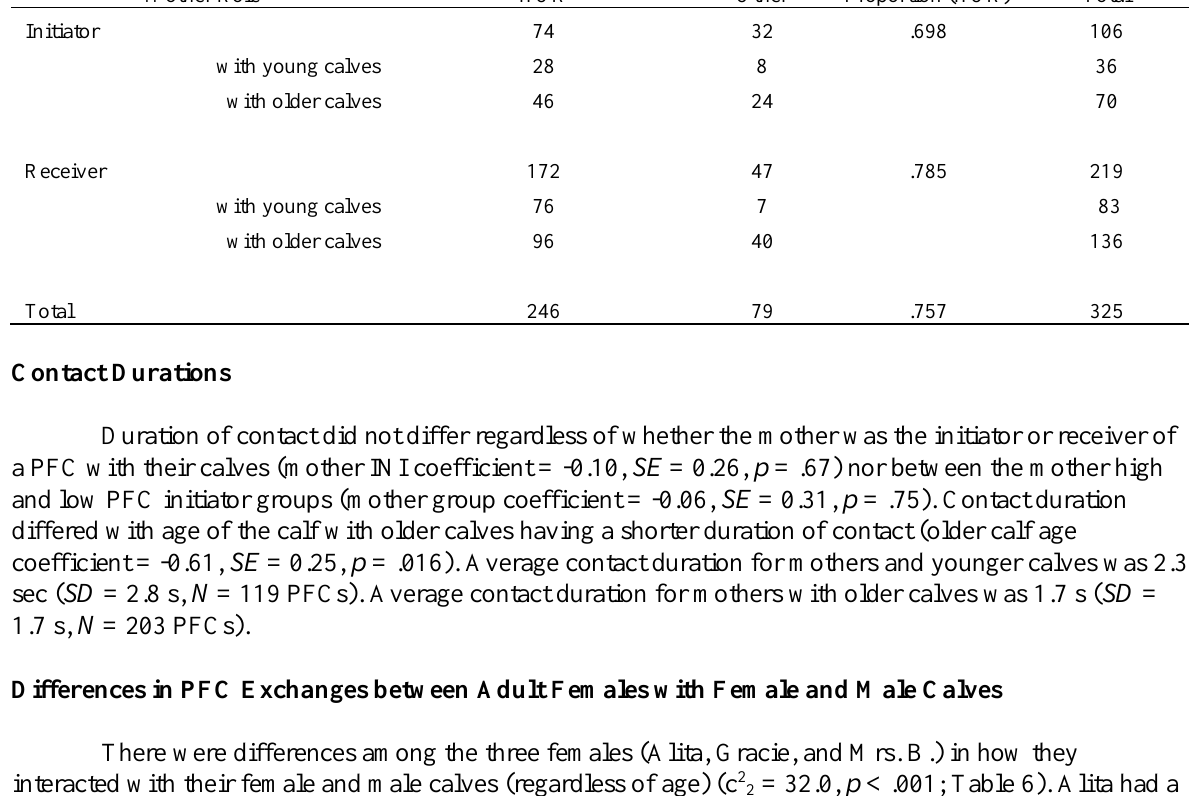
Frequency of Horizontal (HOR) and Other Postures Assumed by Mothers When Initiating and Receiving PFC by Calf Age Mother